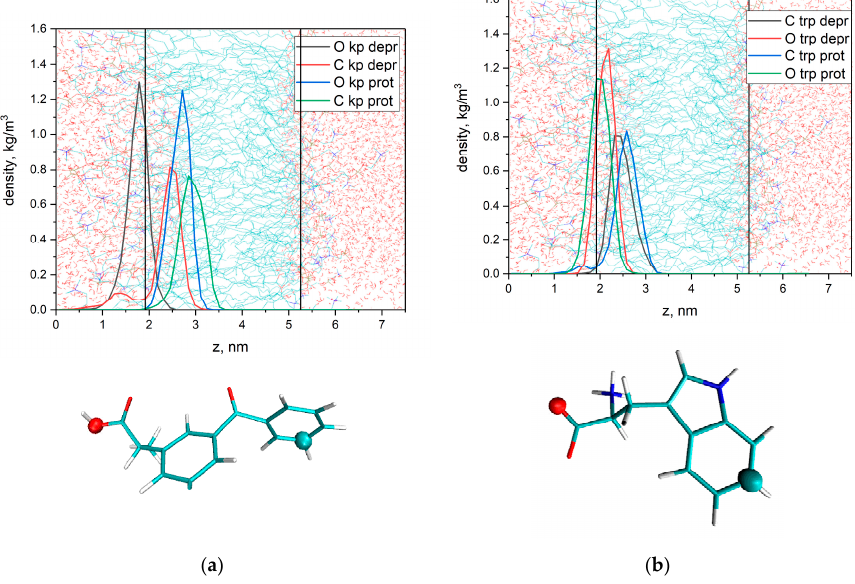
Figure 5. Density profiles of the selected C and O atoms of ketoprofen ( a ) and tryptophan ( b ) in the protonated and deprotonated ketoprofen state. Vertical lines correspond to the centers of density profiles of DMPC N